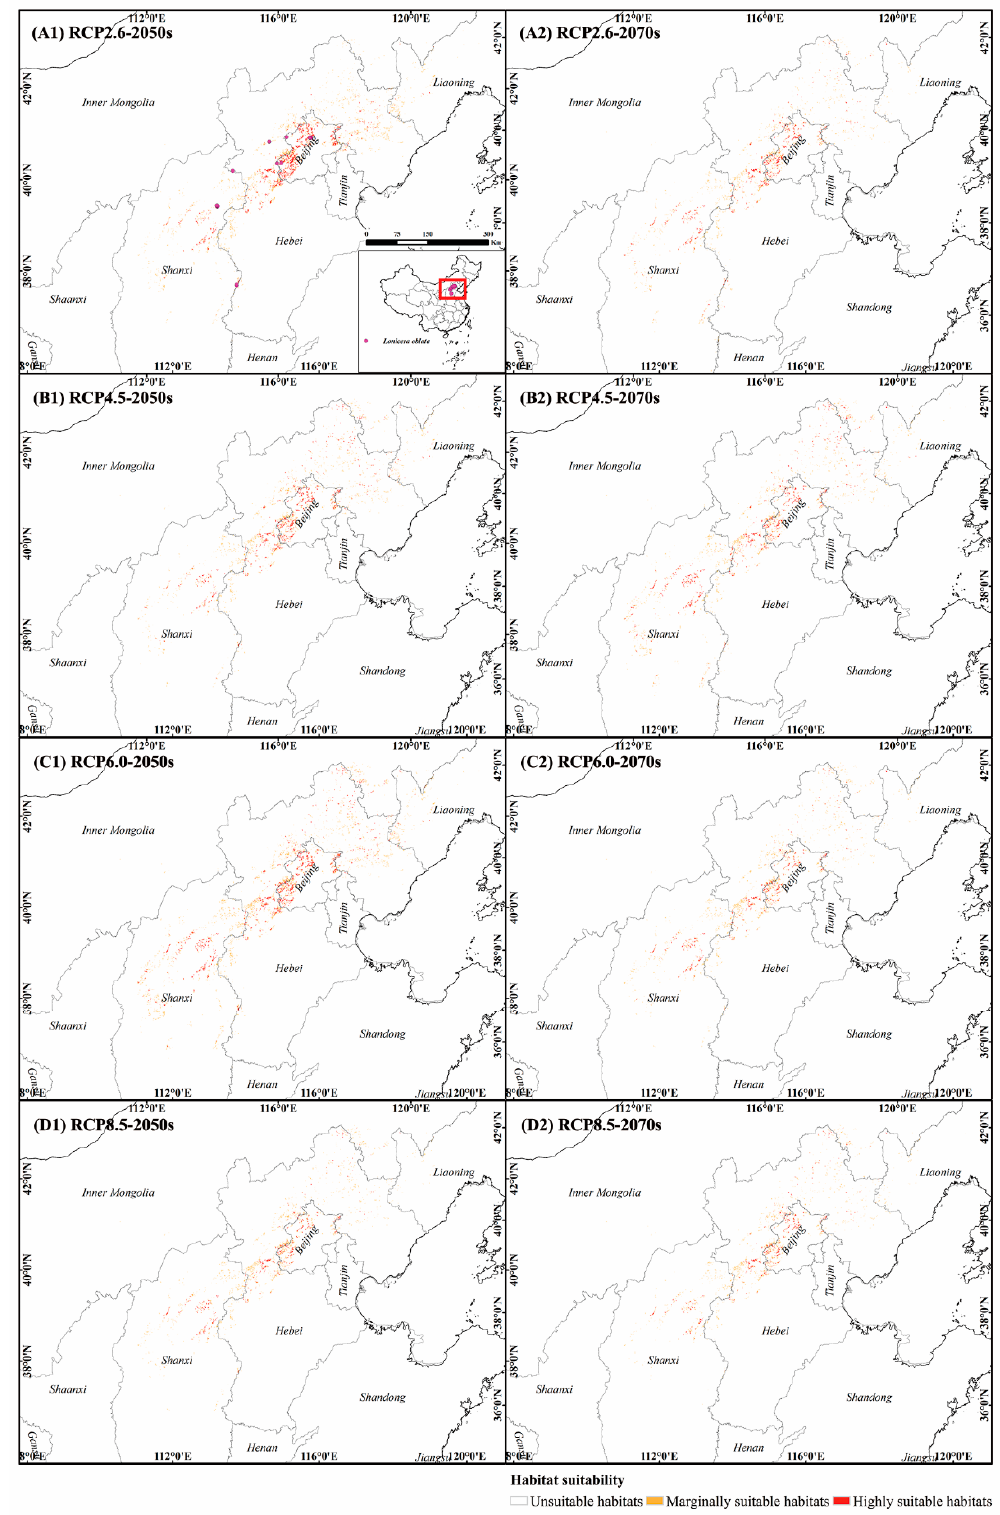
Figure 5. Comprehensive habitat suitability of Lonicera oblata under RCP2.6, RCP4.5, RCP6.0, and RCP8.5 in 2050s and 2070s. ( A1 ) RCP2.6-2050s; ( A2 ) RCP2.6-2070s; ( B1 ) RCP4.5-2050s; ( B2 ) RCP4.5-2070s; ( C1 ) RCP6.0-2050s; ( C2 ) RCP6.0-2070s; ( D1 ) RCP8.5-2050s; ( D2 ) RCP8.5-2070s.